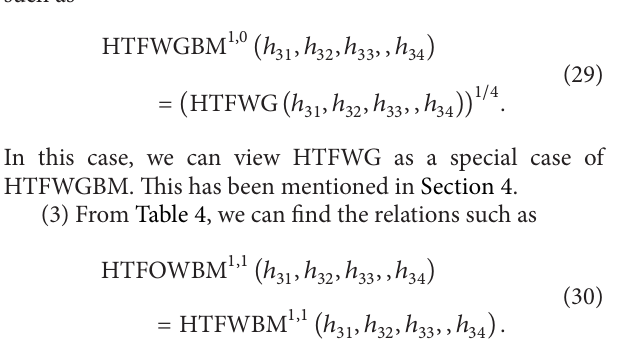
parameters 𝑝, 𝑞 vary. Moreover, the rankings are different when we choose different values of 𝑝, 𝑞 . As the two parameters are symmetrical, we can fix one of them and change the other. Here, we set 𝑞 = 2 , for example. The trends are shown in Figure 1 as the parameter 𝑝 ranges from 0 to 18. From Figure 1, it can be clearly seen